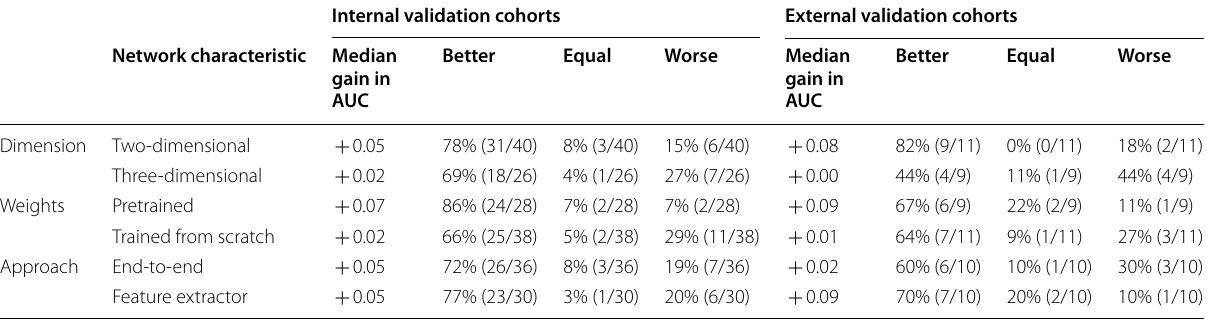
The median gain in area under the curve (AUC) was calculated as the difference in performance from the generic models across all studies that used a network with the corresponding feature. Similarly, the “better”, “equal”, and “worse” columns denote the number of studies that reported better, equal, or worse AUC of the deep model (with the corresponding feature) compared with the generic